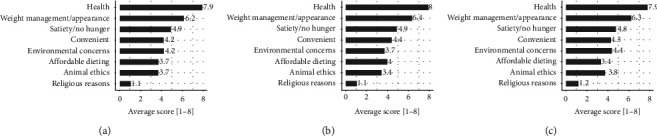
Motives for adopting PBD. (a) Group 1. (b) Group 2. (c) Group 3.